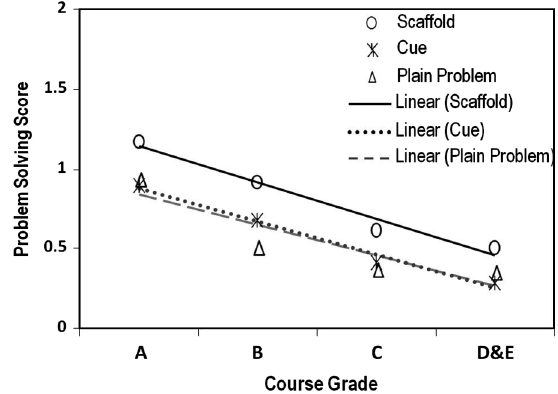
FIG. 5. Problem-solving performance for students at different course grade